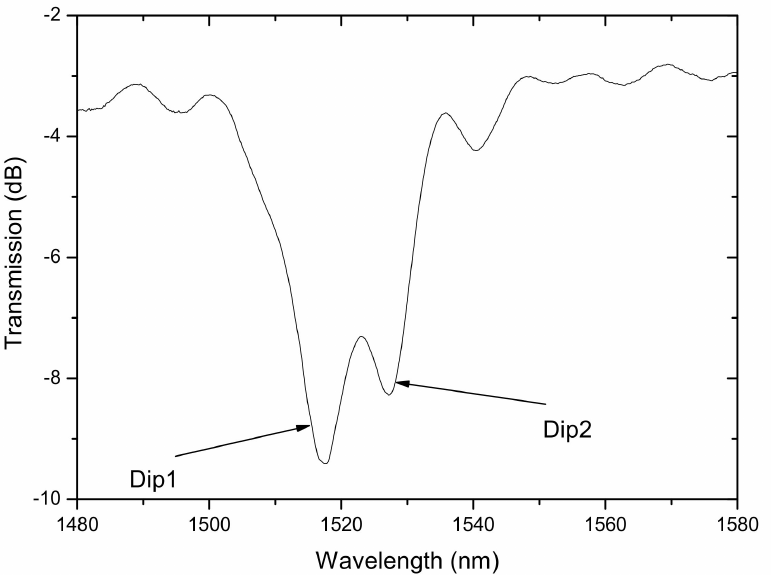
Figure 21. Dual resonances induced by different mechanisms in the B/Ge co-doped fiber. Reprinted with permission from [113]. © 2021 The Optical Society.